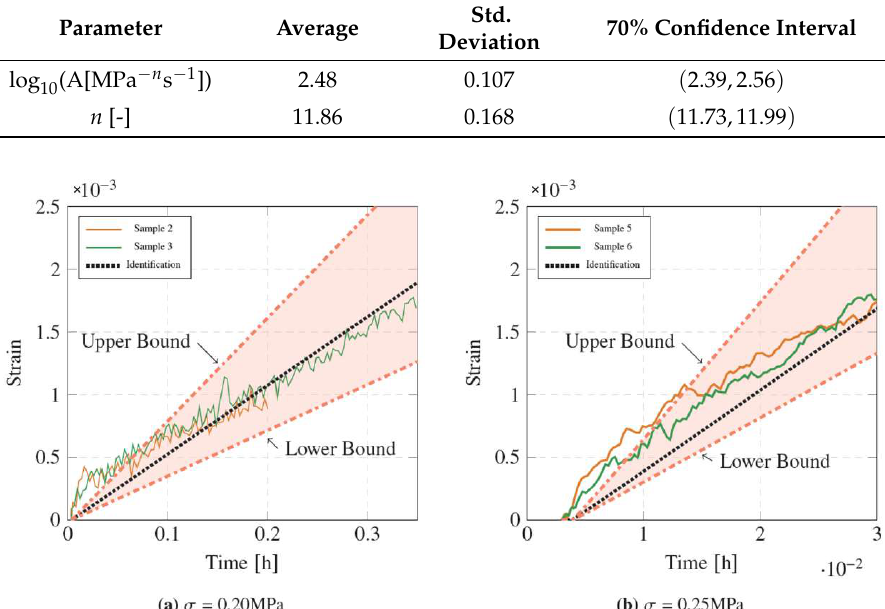
Figure 9. Tensile creep identification results at T = 1300 ◦ C—Reduced number of